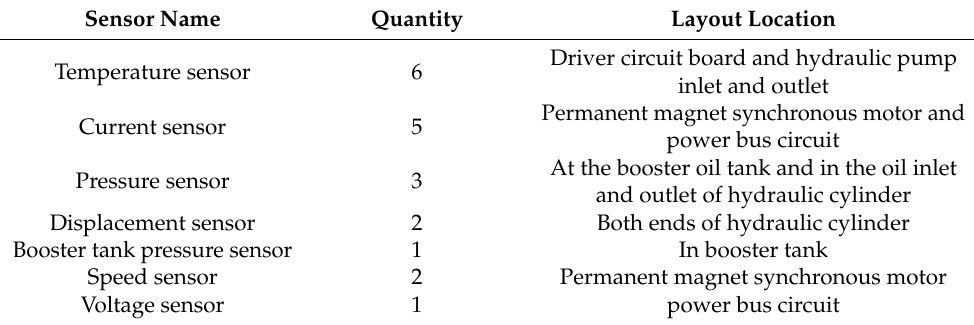
Table 1. Sensor layout